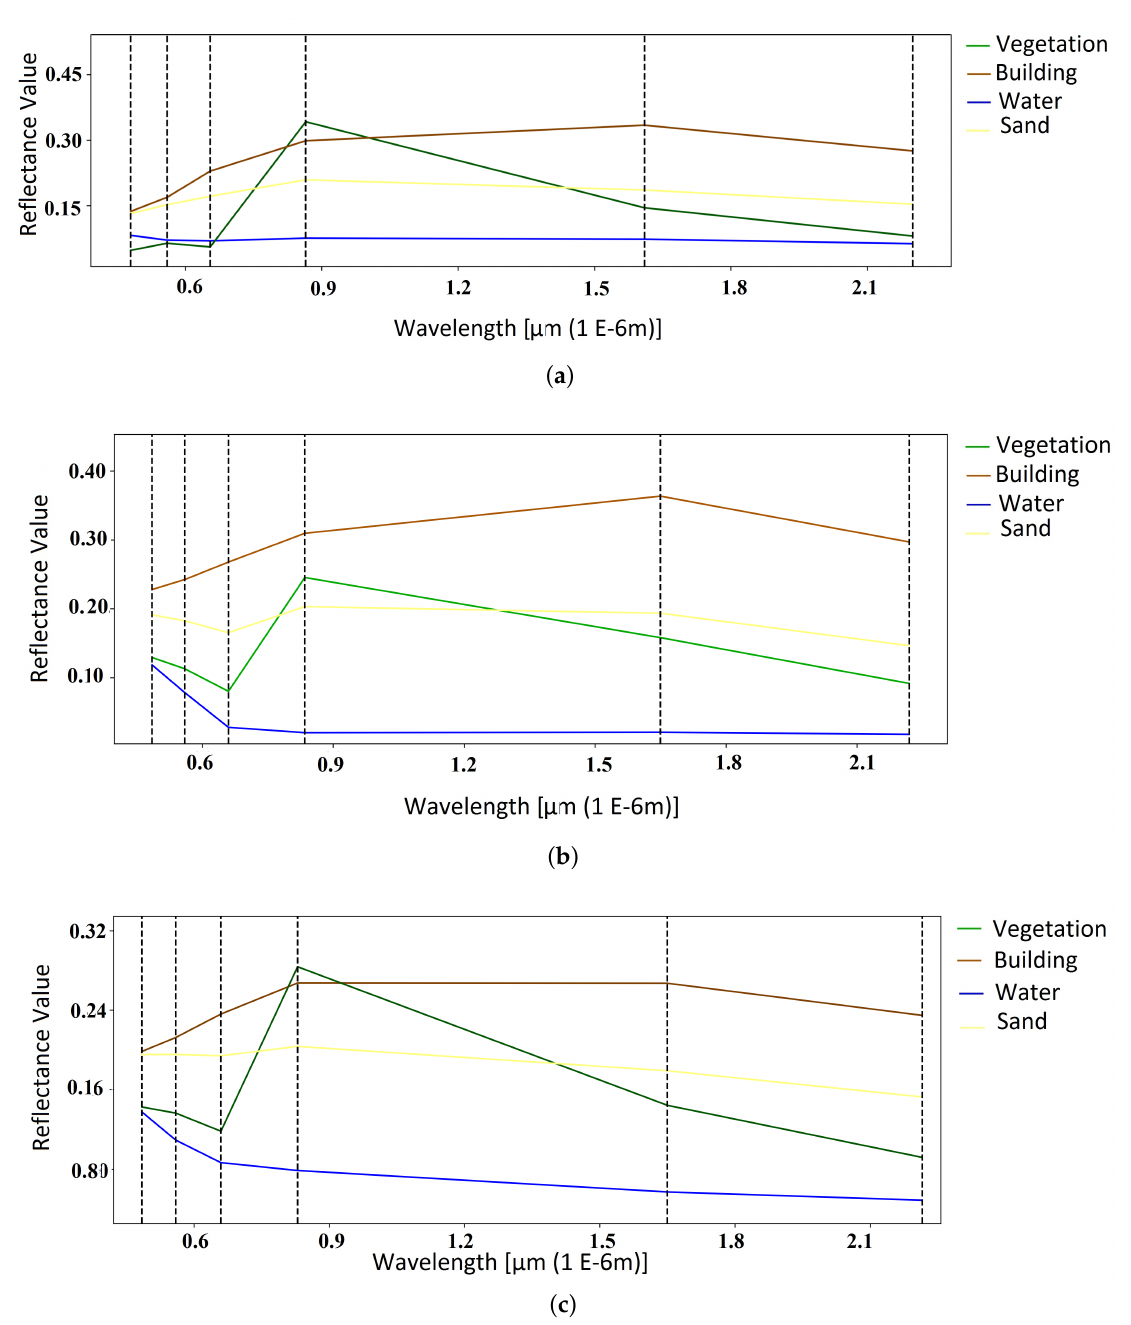
Figure 4. Spectral signature graphs of main land covers analyzed in the Adra Delta from different dates and Landsat sensors: ( a ) OLI Landsat image captured on 24 June 2013. ( b ) ETM+ Landsat image captured on 28 July 1990. ( c ) TM Landsat image captured on 18 July